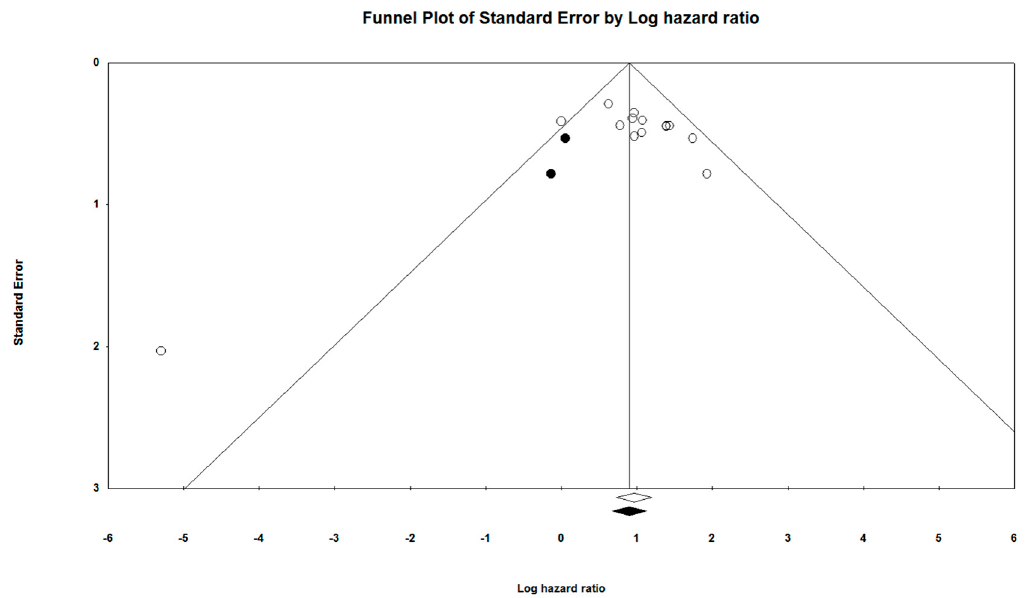
Figure 15. Funnel plot for the studies prognostic of DFS.